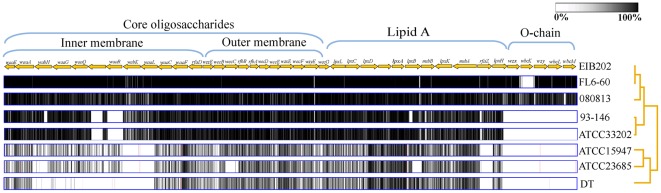
LPS related genes of Edwardsiella strains.Mauve progressive alignment of the concatenated coding sequences of 8 sequenced Edwardsiella strains using E. tarda EIB202 as reference. Arrows indicate the gene coding orientation in EIB202 genome. The dendrogram is derived from NJ analysis of concatenated amino acid sequences of LPS biosynthesis genes with 1,000 bootstrap iterations. Gradient bar indicated the sequence similarity of LPS coding sequences of Edwardsiella strains to those of EIB202.